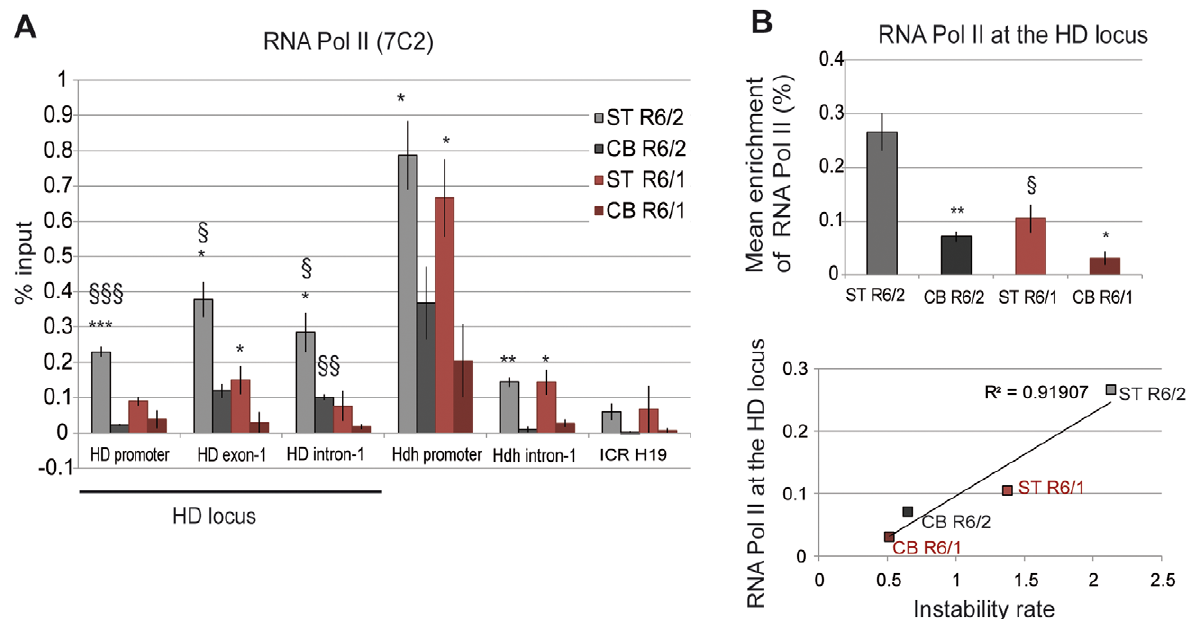
Figure 6. RNA Pol II at the HD locus in R6/1 and R6/2 striatum and cerebellum. A. ChIP analyses from the striatum and the cerebellum of R6/ 1 and R6/2 mice at late-pathological stages (36-wk and 12-wk, respectively) using an antibody to RNA Pol II (7C2), which recognizes phosphorylated and unphosphorylated forms of the enzyme. Error bars, sem; *, inter-tissue comparisons; 1 , inter-mouse line comparisons. *, p , 0.05; 1 , p , 0.05. B. Upper panel. Global analysis of the level of Me3H3K4 at the HD locus, assessed as in Figure 4. Error bars, sem; *, p , 0.05; **, p , 0.01 (inter-tissue comparison); 1 , p , 0.05 (inter-mouse comparison). Lower panel. Correlative analysis of CAG instability rates and RNA Pol II levels at the HD locus. R6/1 mice of 36 weeks and R6/2 mice of 12 weeks were used for correlation